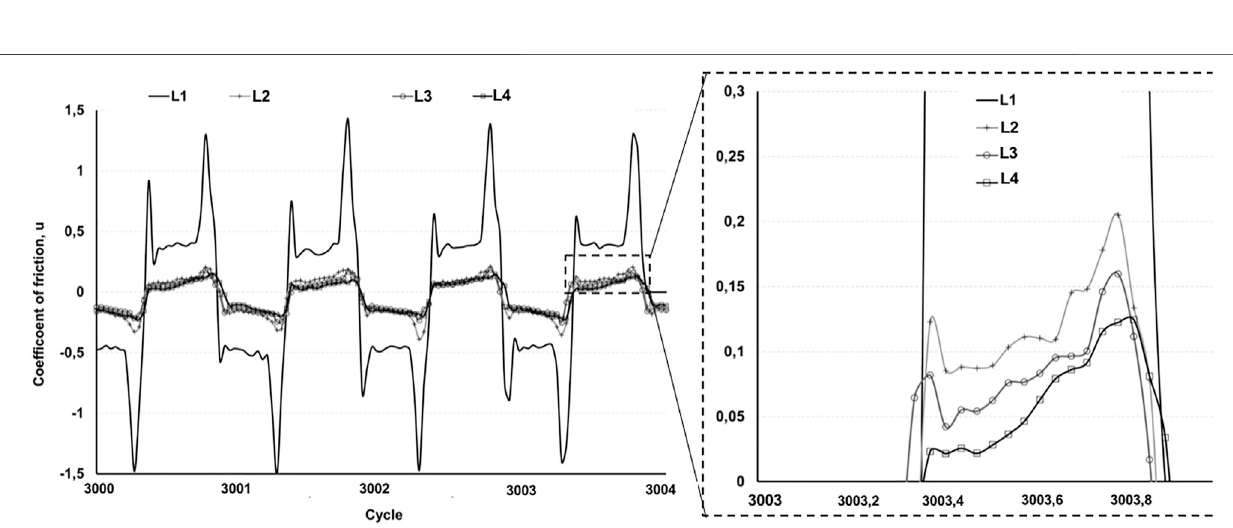
Frontiers in Mechanical Engineering |